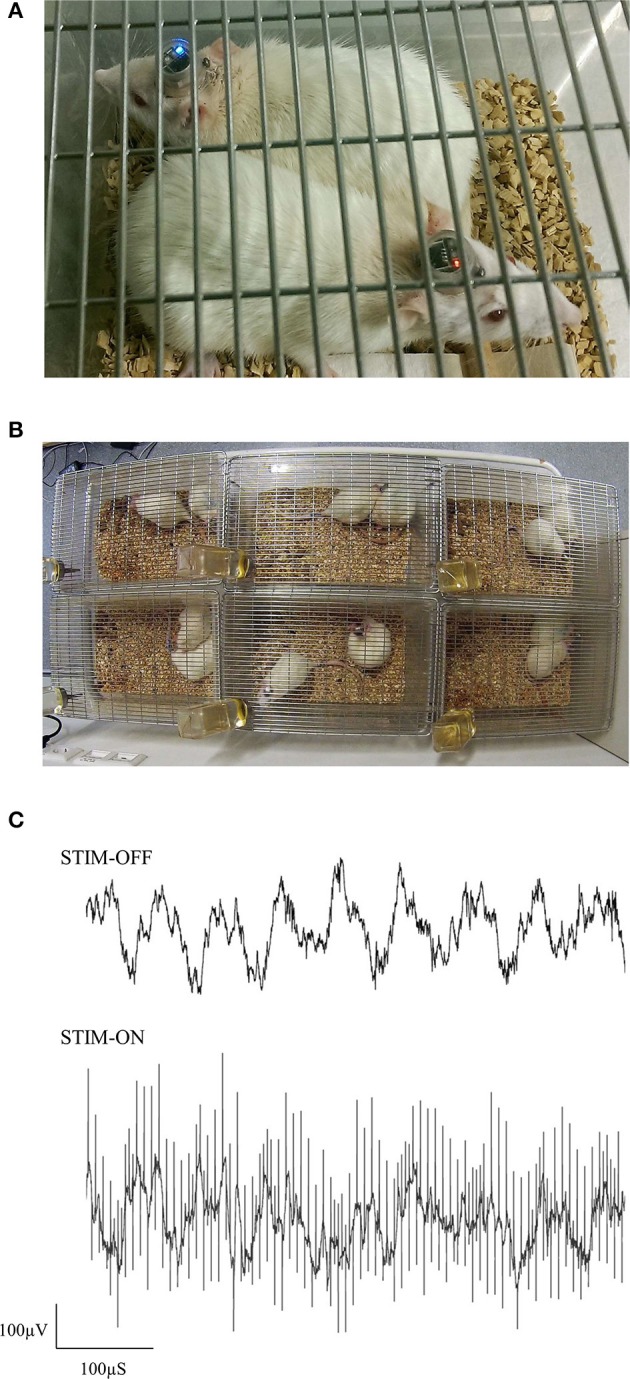
Photographs of pair-housed rats during a stimulation session (A,B). EEG from dCA1 is shown with and without high-frequency stimulus pulses (C). Having an electrically isolated stimulator ensured that only volume conduction artifacts were present in the EEG, due to stimulus pulses propagating through the brain.